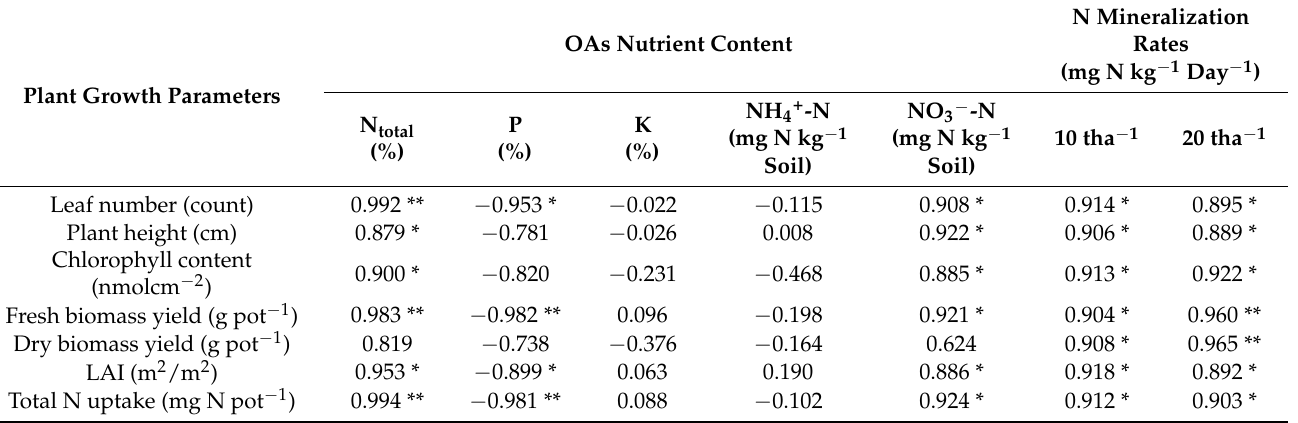
Table 7. Pearson correlation coefficient between nutrient content and N mineralization of composted organic amendments and plant growth parameters and N uptake at final